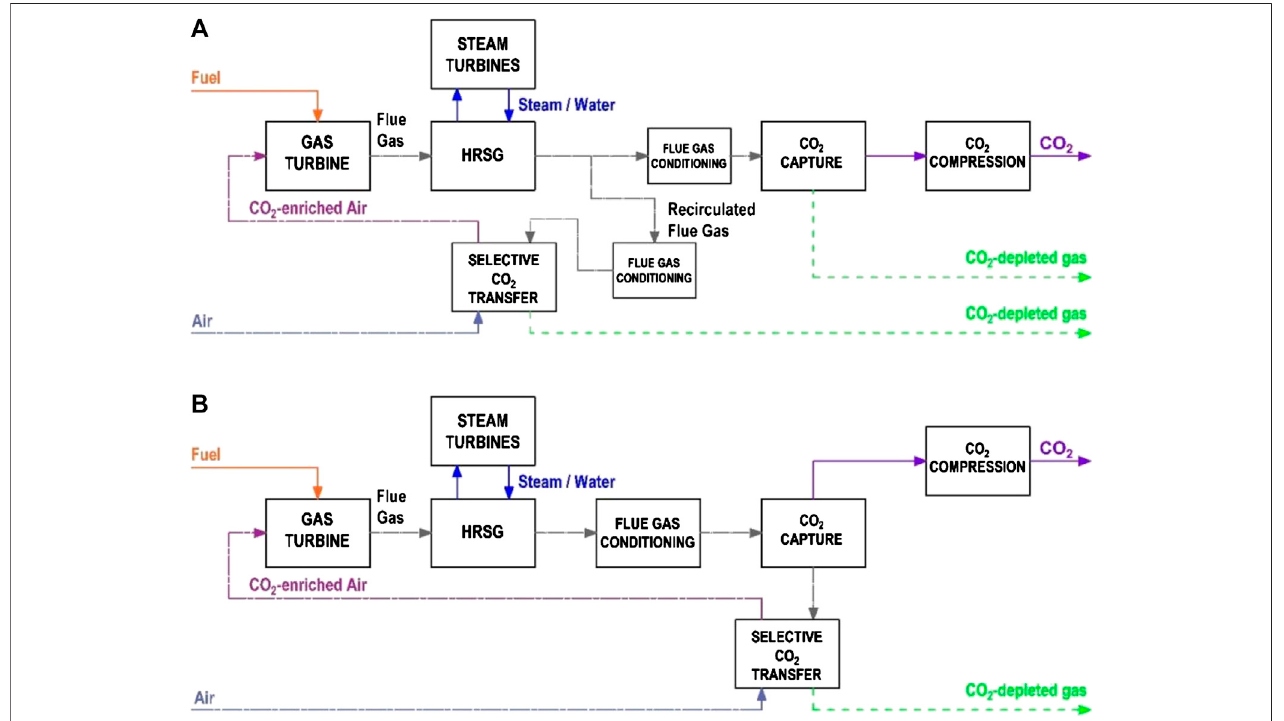
FIGURE 1 | Block fl ow diagrams for a CCGT plant with PCC and with either (A) S-EGR in parallel or (B) S-EGR in series.